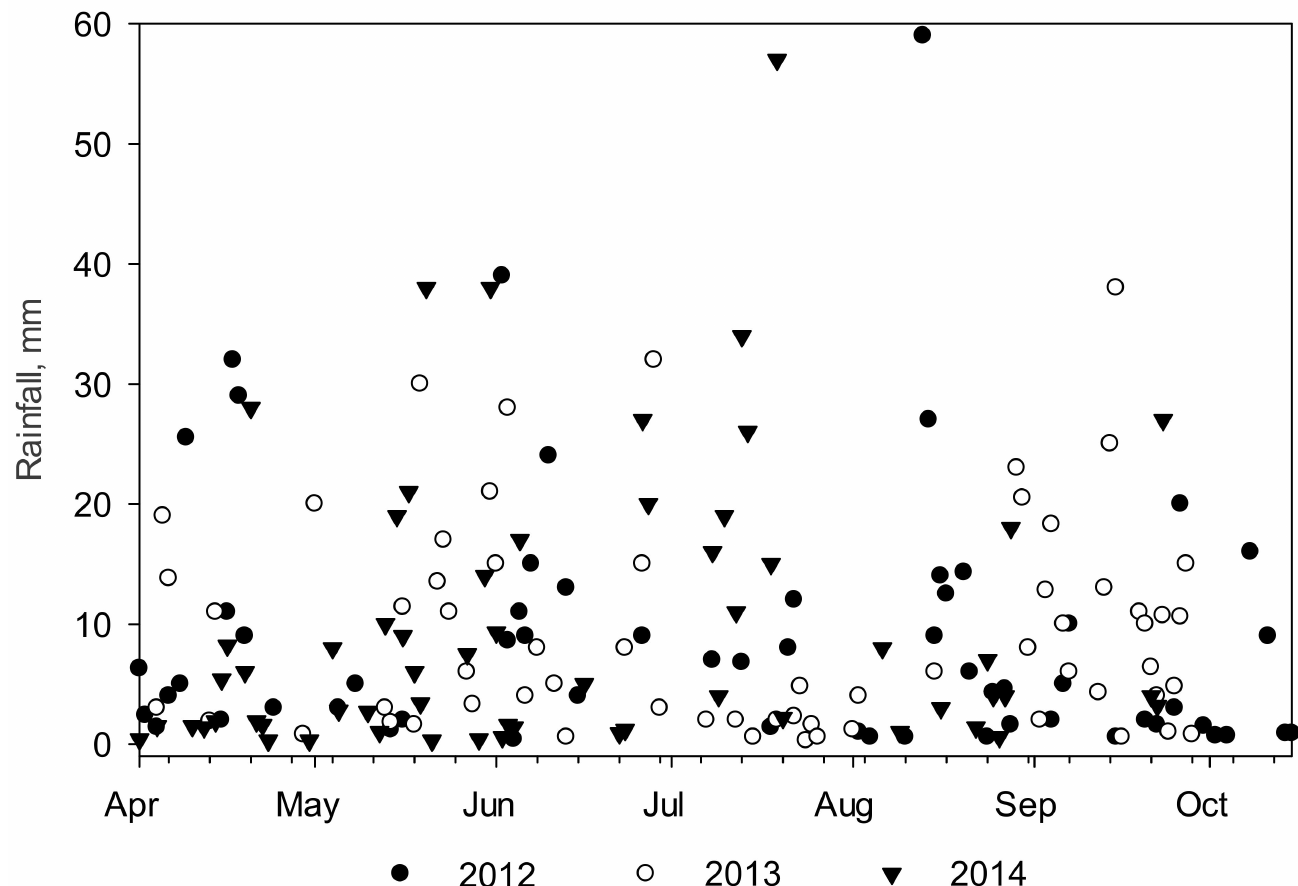
Figure 1. Rainfall conditions from April to October 2012–2014 at the Velykosnyatynky research station. Each treatment was replicated three times for a total of 15 plots. Each tested plot